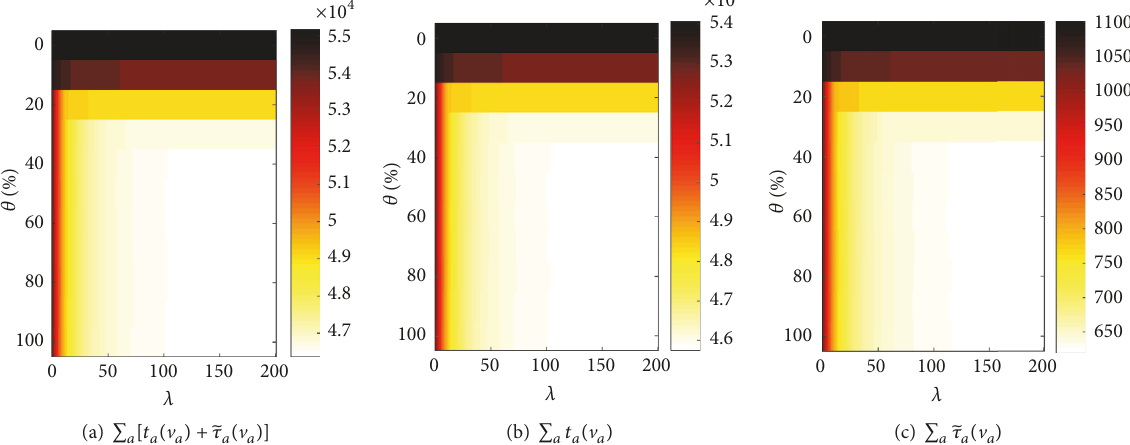
Figure 5: System costs with a common UE and an environmental advocacy UE: (a) total cost; (b) travel time; (c) emission exposure.